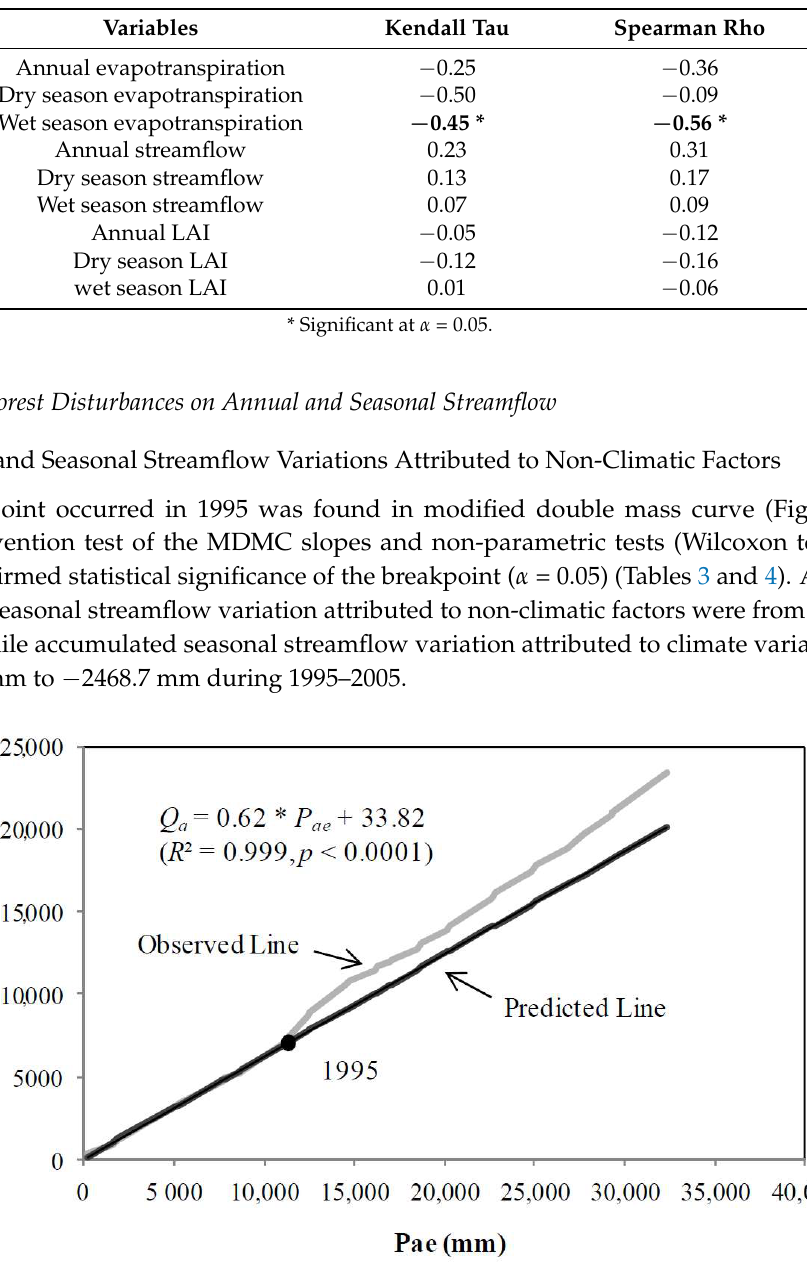
Figure 5. Modified double mass curve of accumulated seasonal streamflow ( Q a ) and accumulated seasonal effective precipitation ( P ae ). Table 3. ARIMA Intervention for slope of MDMC (modified double mass curve).